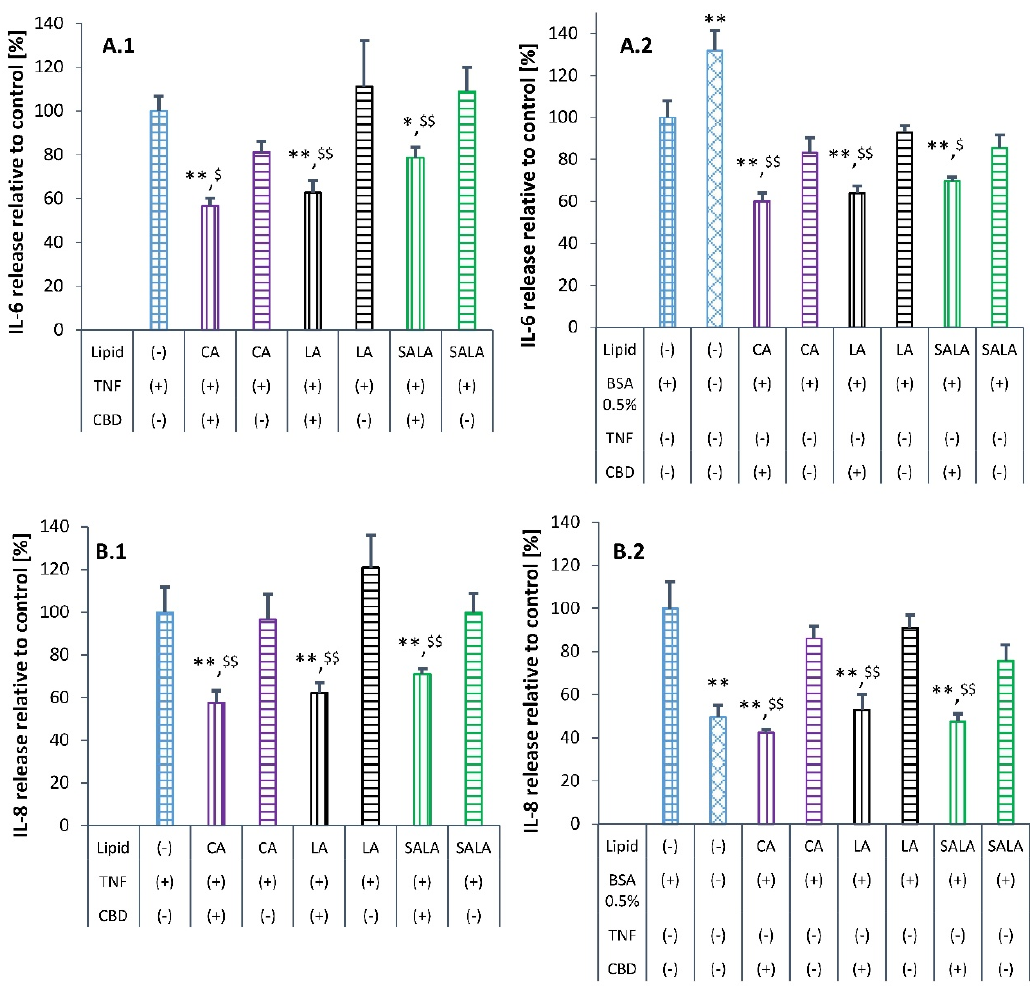
Figure 8. Influence of lipid-stabilized nanoparticles on IL-6 ( A.1 , A.2 ) and IL-8 ( B.1 , B.2 ) secretion in TNF- α -induced and non-induced HaCaT cells. * Indicates comparison to control (100%). $ indicates comparison to unloaded LSNs of the same type. */ $ p value < 0.05, **/ $$ p value < 0.01. The p values calculated by one-way ANOVA, followed by post hoc Tuckey test. Values are presented as mean ± SD.